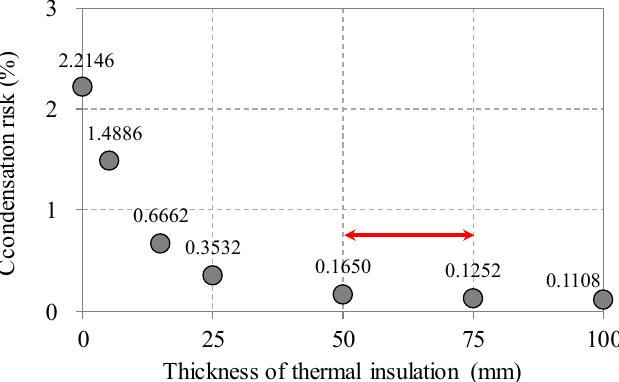
Figure 11. Condensation risk with different thicknesses of insulation of the external wall (0–100 mm).